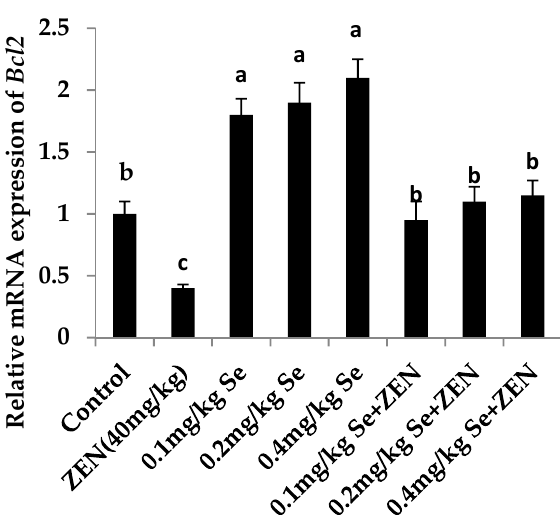
Figure 4. Effect of ZEN, different concentration of Se and their co-treatment on the relative mRNA expression of Bcl2 in mice testicular tissue. Values are mean ± SE of twenty mice in each group. a–c Means with different letters are significantly different, p < 0.05 . a p < 0.05 vs. control group and ZEN-treated group, b p < 0.05 vs. ZEN-treated group, c p < 0.05 vs. control group.